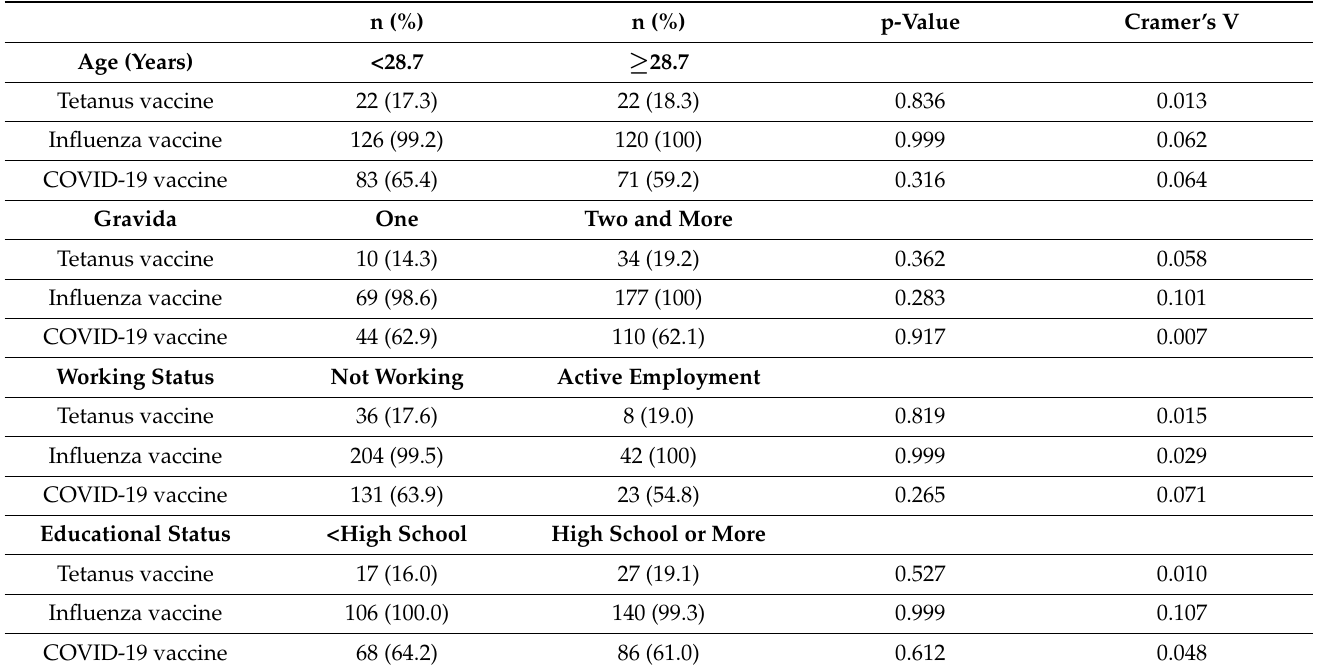
Table 4. Evaluation of unvaccinated individuals according to demographic